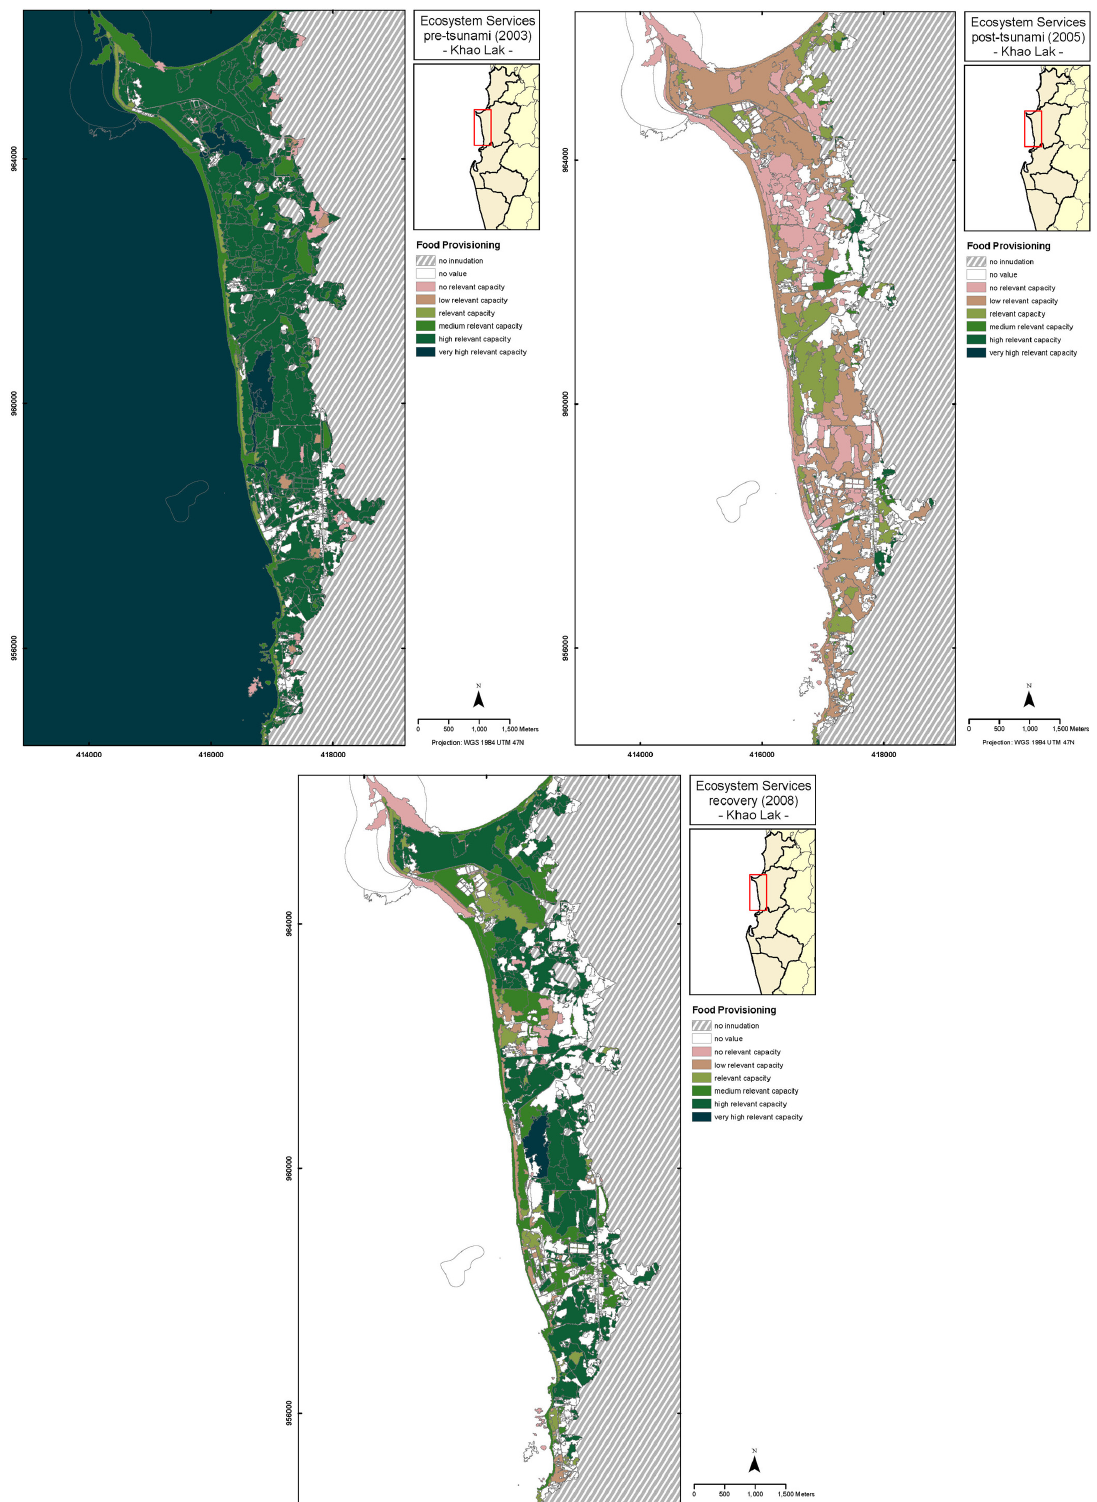
Fig. 7. Map showing the spatial distribution of the ecosystem service “food provisioning” before the tsunami 2003 (upper panel, left), after the tsunami (01/2005, upper panel, right) and after a recovery time (02/2008, lower panel). White areas represent areas not included in the analysis or no data available on damages or recovery of LULC classes (e.g. ocean, coral reefs, and sea-grass, rubber).